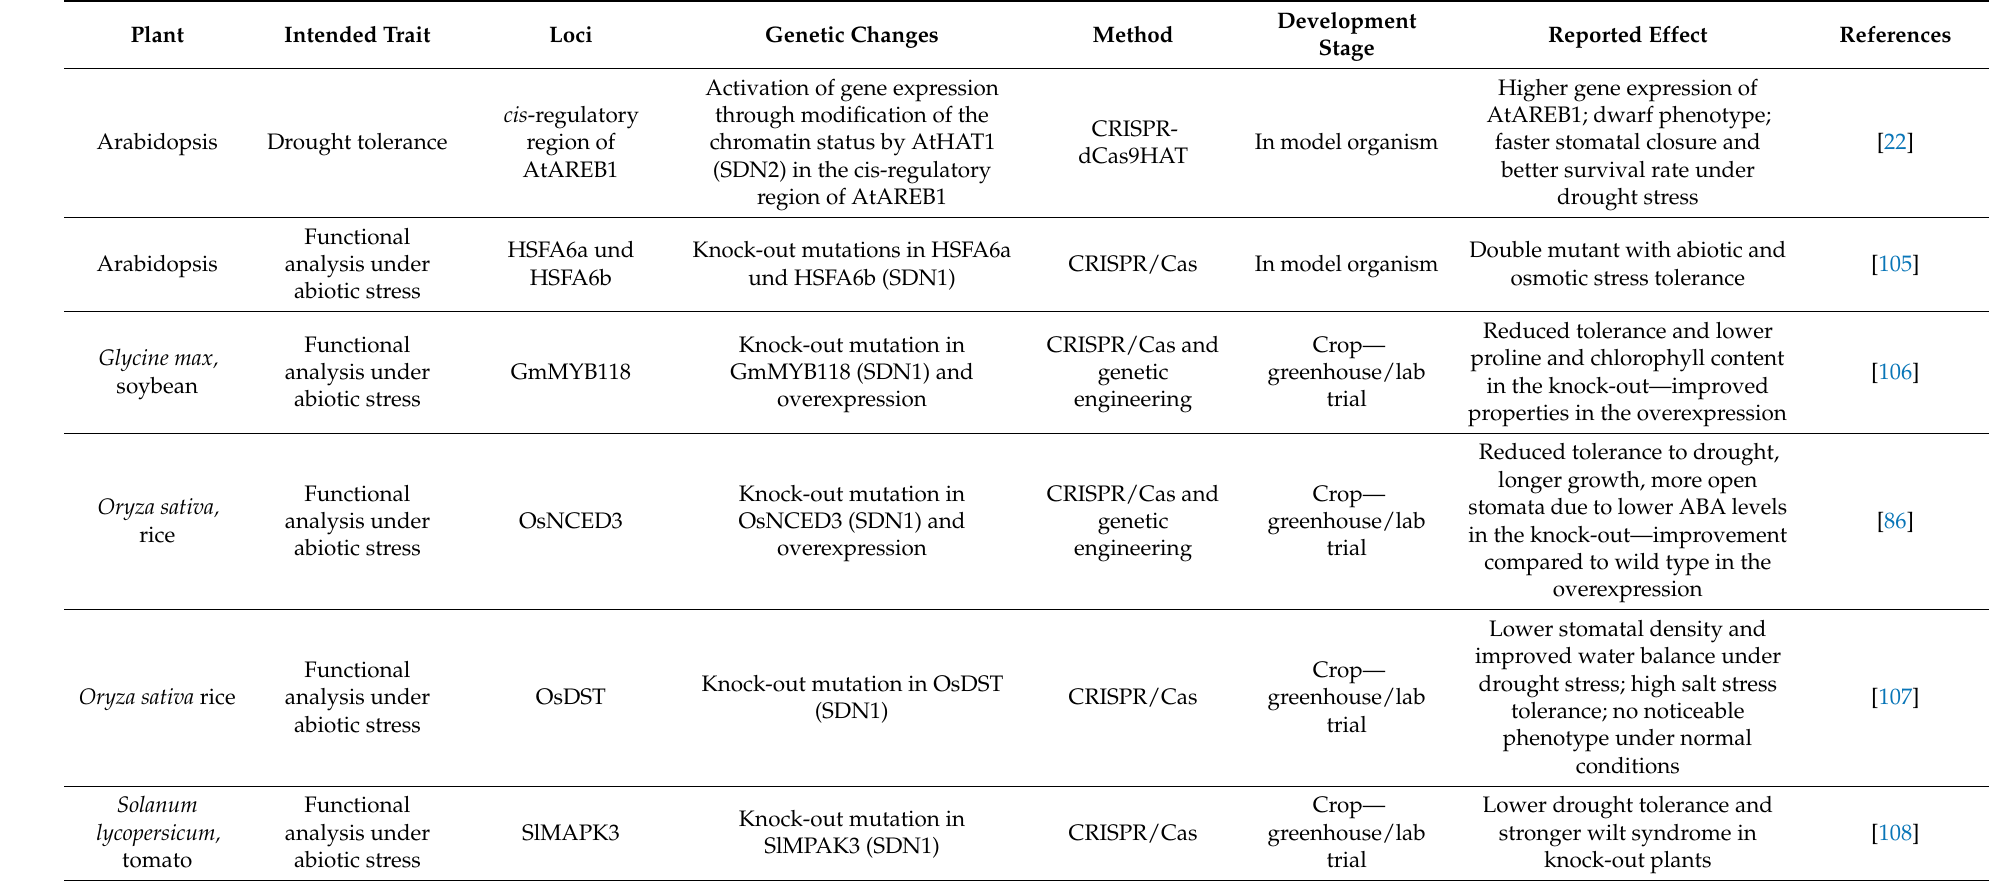
Table 3. Overview over basic research on traits conferring increased drought